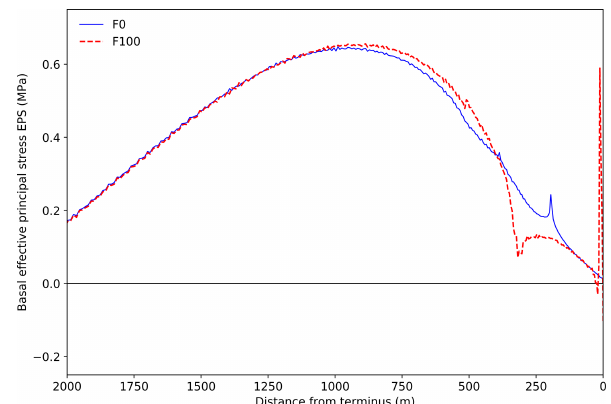
Figure 9. Comparison of basal stresses using the Coulomb sliding law with full water pressure at the ice–bed interface, before (F0) and after (F100) cutting of a 100m notch. Ungrounding occurred between approximately 200 and 380m for F0 and between approx- imately 20 and 510m for F100.